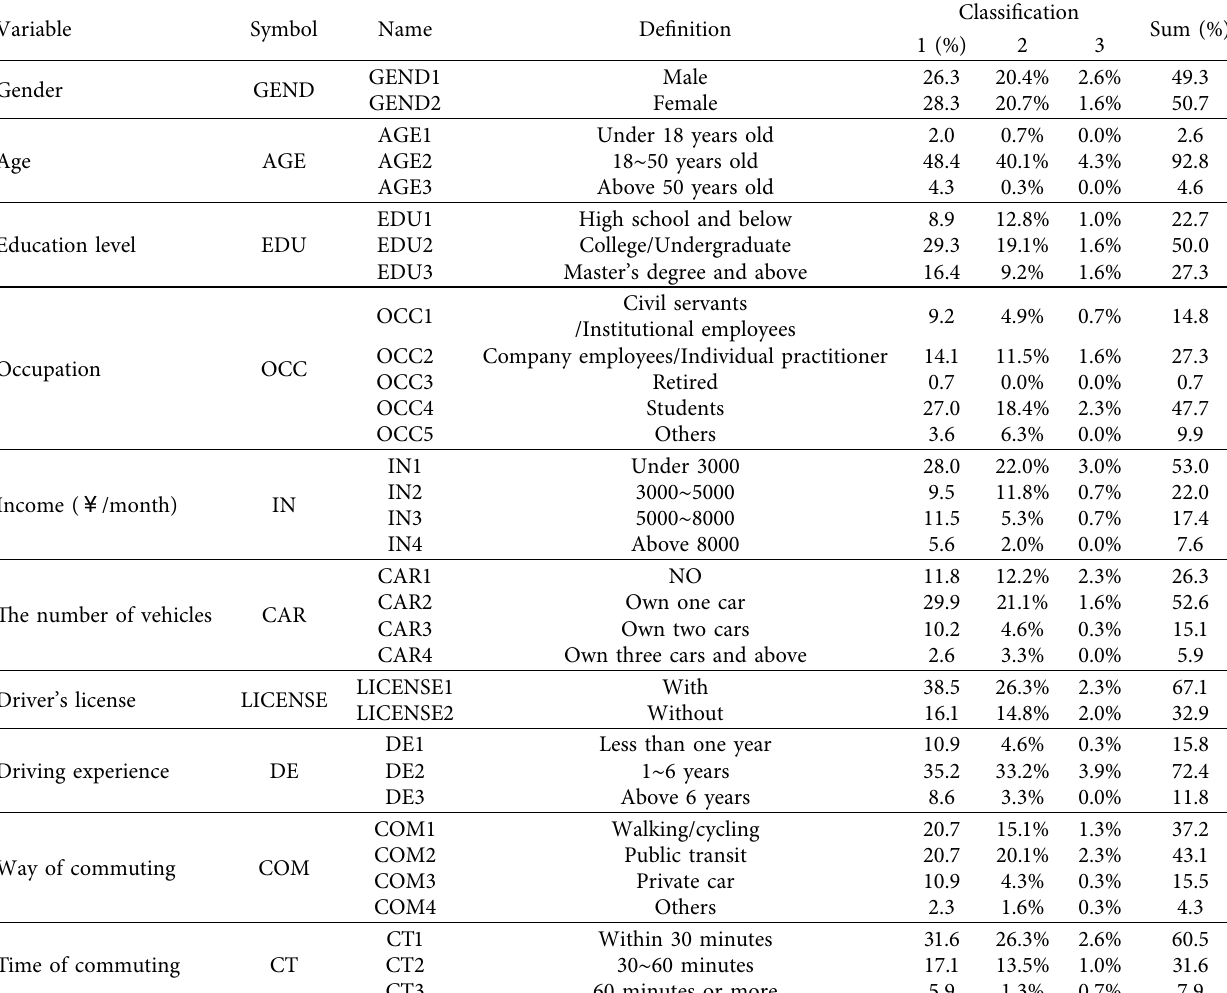
Table 3: Sample descriptive statistics.